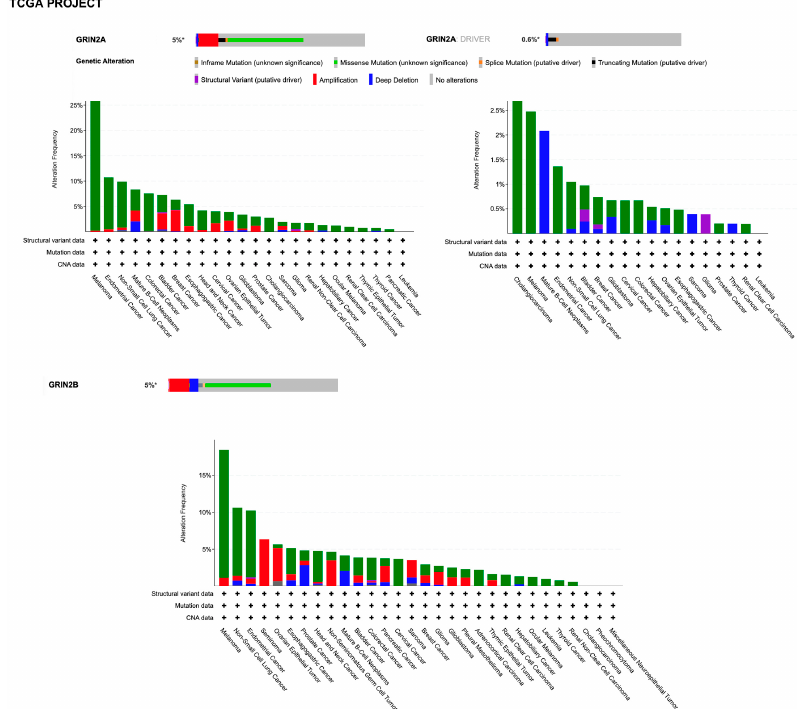
Figure 6. Summary graph of genomic alterations of GRIN2A and GRIN2B genes and their distribution in cancer studies from TCGA pan-cancer Project available in the cBioPortal. However, it must be considered that the types of di ff erent cancers in these resources is not proportional to the relative burden of those cancers within the population. Discrep- ancies in alterations can be found between the two datasets due to technical di ff erences in sample preparation and sequencing, the la tt er including the unbiased tumor–normal ex- ome sequencing of TCGA, the focus of which is on primary tumors, versus the clinical context of GENIE, which is enriched with samples from patients with late-stage, heavily treated cancer. By searching for GRIN2A as a cancer driver gene (i.e., only mutations, fu- sions, and copy number alterations which are driver events, as de fi ned in OncoPrint), it was found that genetic alterations with the putative driver function are identi fi ed in 0.5% and 0.6% of all tumors with melanoma prevalence in the GENIE and TCGA projects, re- spectively (Figures 5 and 6). The criteria used by the algorithms to assess ampli fi ed genes as drivers take into account a very high fold copy number and gene expression, which is not the case for GRIN2A . Based on the loss of tumor suppressor activity in melanoma, GRIN2A has been annotated as a tumor suppressor gene in OncoKb (accessed on 20 Jan- uary 2023, h tt ps://www.oncokb.org/). However, careful analysis of the basic gene and pro- tein characteristics should be carried out once a potential cancer driver gene has been identi fi ed by sophisticated algorithms. Previous whole-exome sequencing has demon- strated that melanoma tumors harbor mutations in the GRIN2A gene [108] and patients with GRIN2A mutations have more aggressive disease [109]. One possible mechanism of action and consequence of GRIN2A mutations that interfere and reduce the NMDAR channel function may involve cell death protection under the conditions of NMDAR over- activation, in which excessive calcium uptake induces cell excitotoxicity. On the other